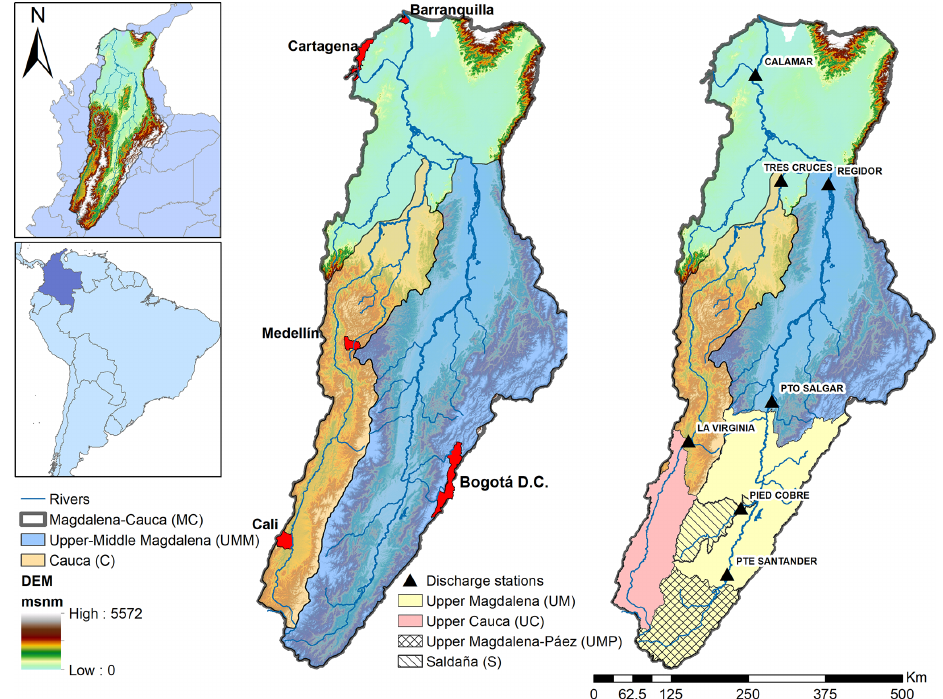
Figure 1. Location of the MC Basin in Colombia, as well as the sub-basins considered in this study. The triangles represent the locations of gauge stations measuring streamflow at the outlets of each (sub)